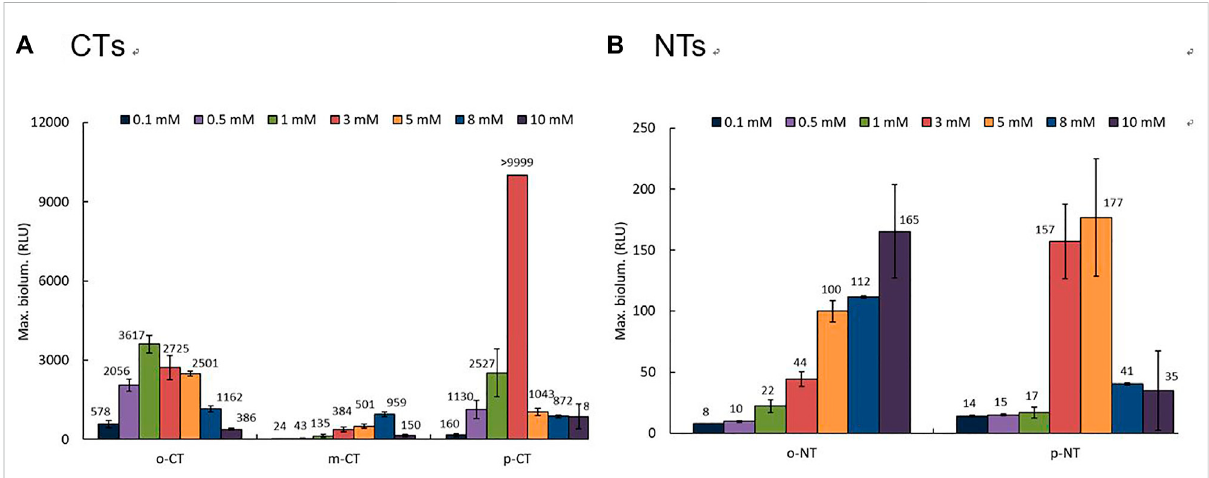
FIGURE 3 Pro fi les of maximum bioluminescence intensity of KG1206 at the exposure to different concentrations of inducer: (A) three CTs and (B) two NTs.